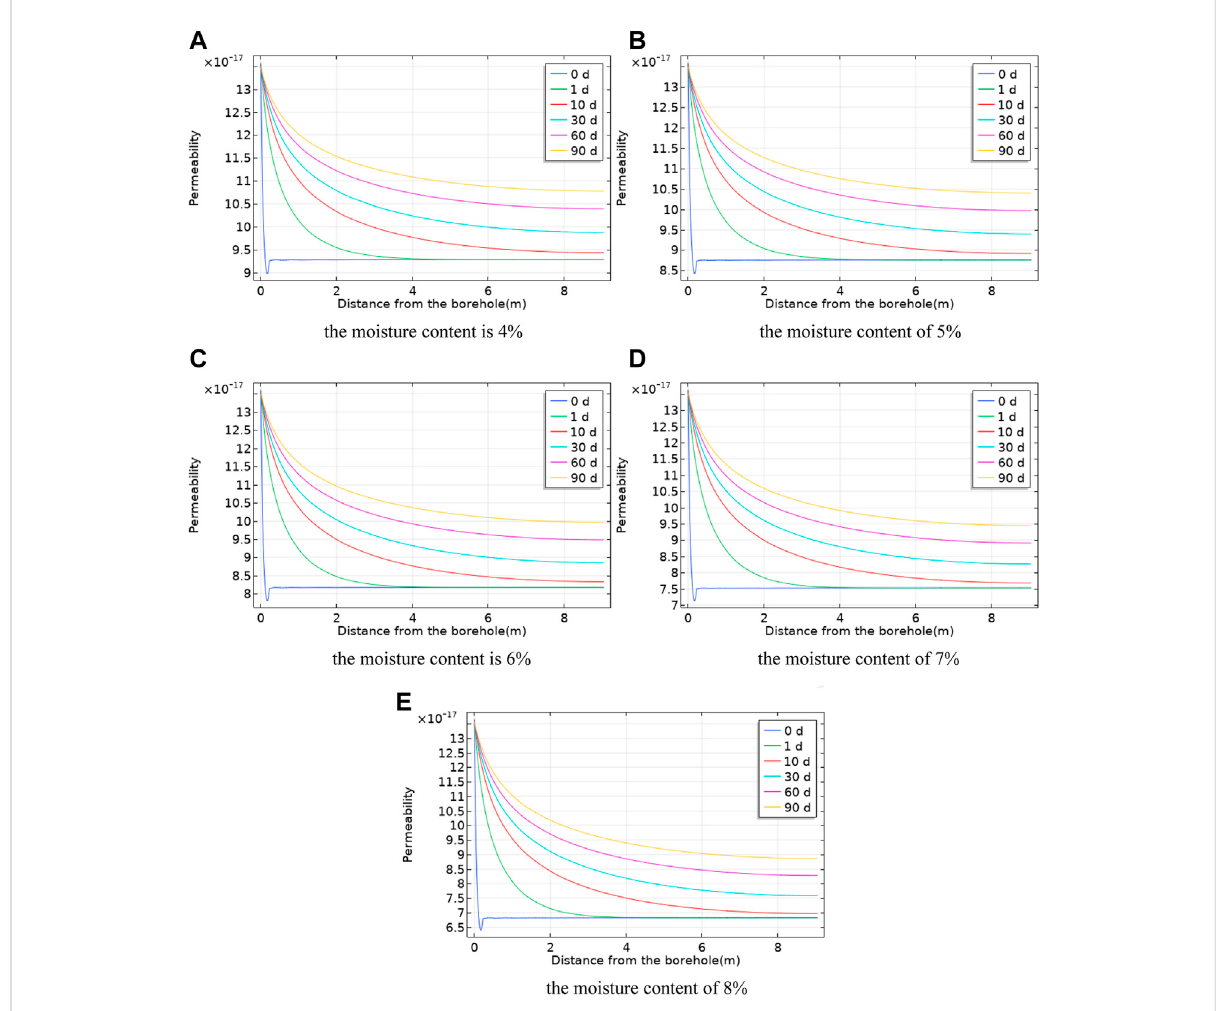
FIGURE 7 Evolution of coal permeability along the long axis of equivalent ellipsoid-like holes under different water content. (A) The moisture content is 4%, (B) the moisture content is 5%, (C) the moisture content is 6%, (D) the moisture content is 7%, and (E) the moisture content is 8%.